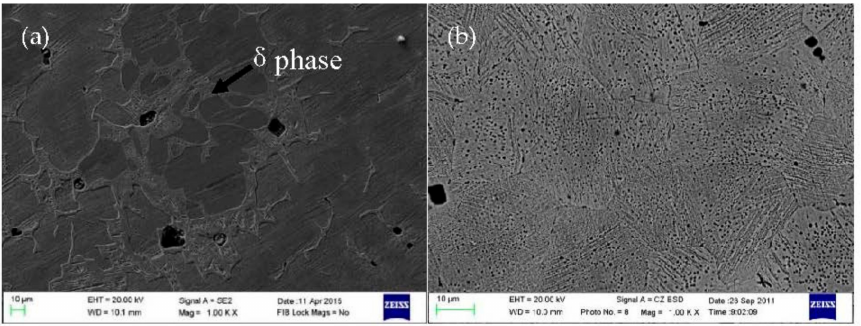
Figure 4. SEM micrographs showing microstructure of the samples: ( a ) Etched Cu-10Sn-2Zn alloy sample; ( b ) Etched Cu-10Sn-2Zn-1.5Fe-0.5Co alloy sample